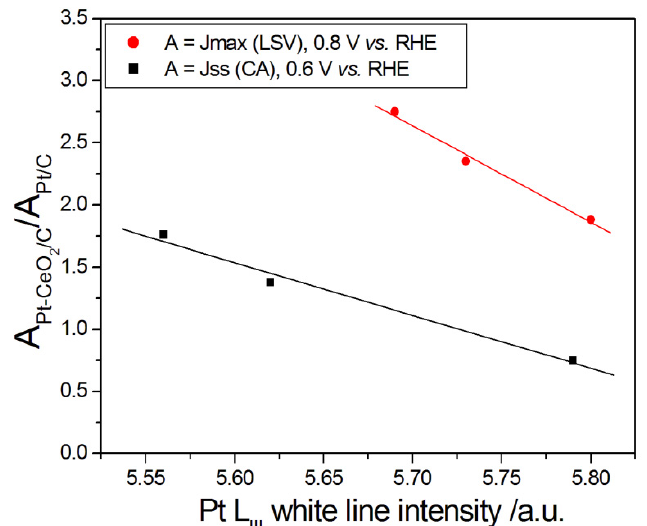
Figure 8. Dependence of the A PtCeO2 /C/A Pt/C ratio, where A = J ss (CA, 0.6 V vs. RHE) and J max (LSV, 0.8 V vs. RHE) on Pt L III white line integrated intensity.